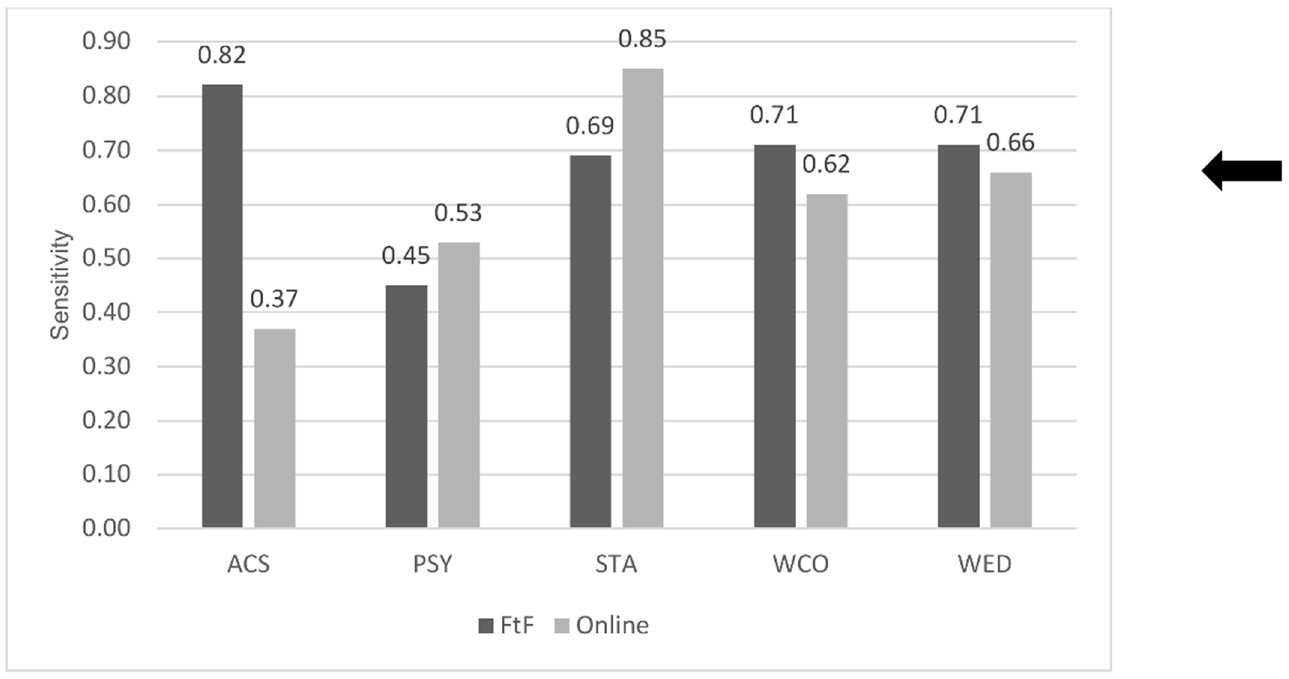
Figure 2. Prediction of at ‐ risk students (sensitivity scores) by instructional modality and course type.